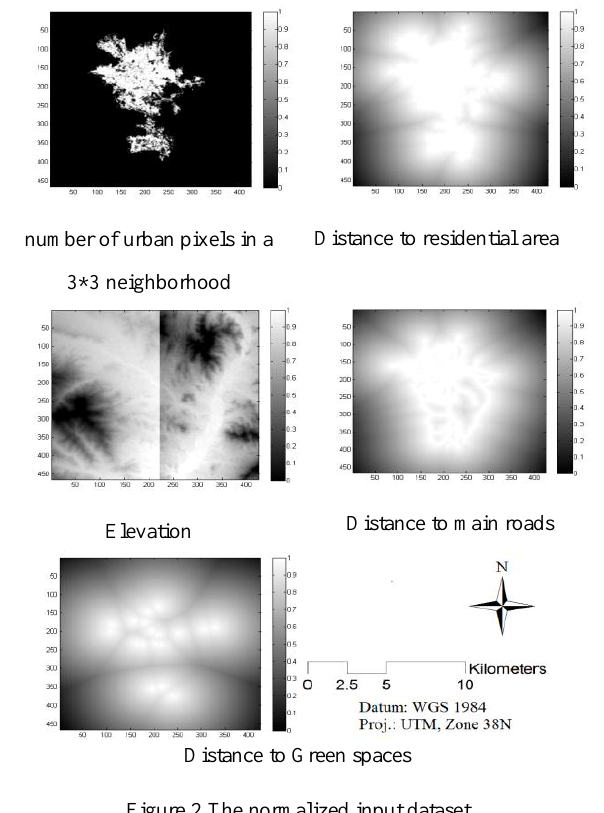
Figure 2 The normalized input